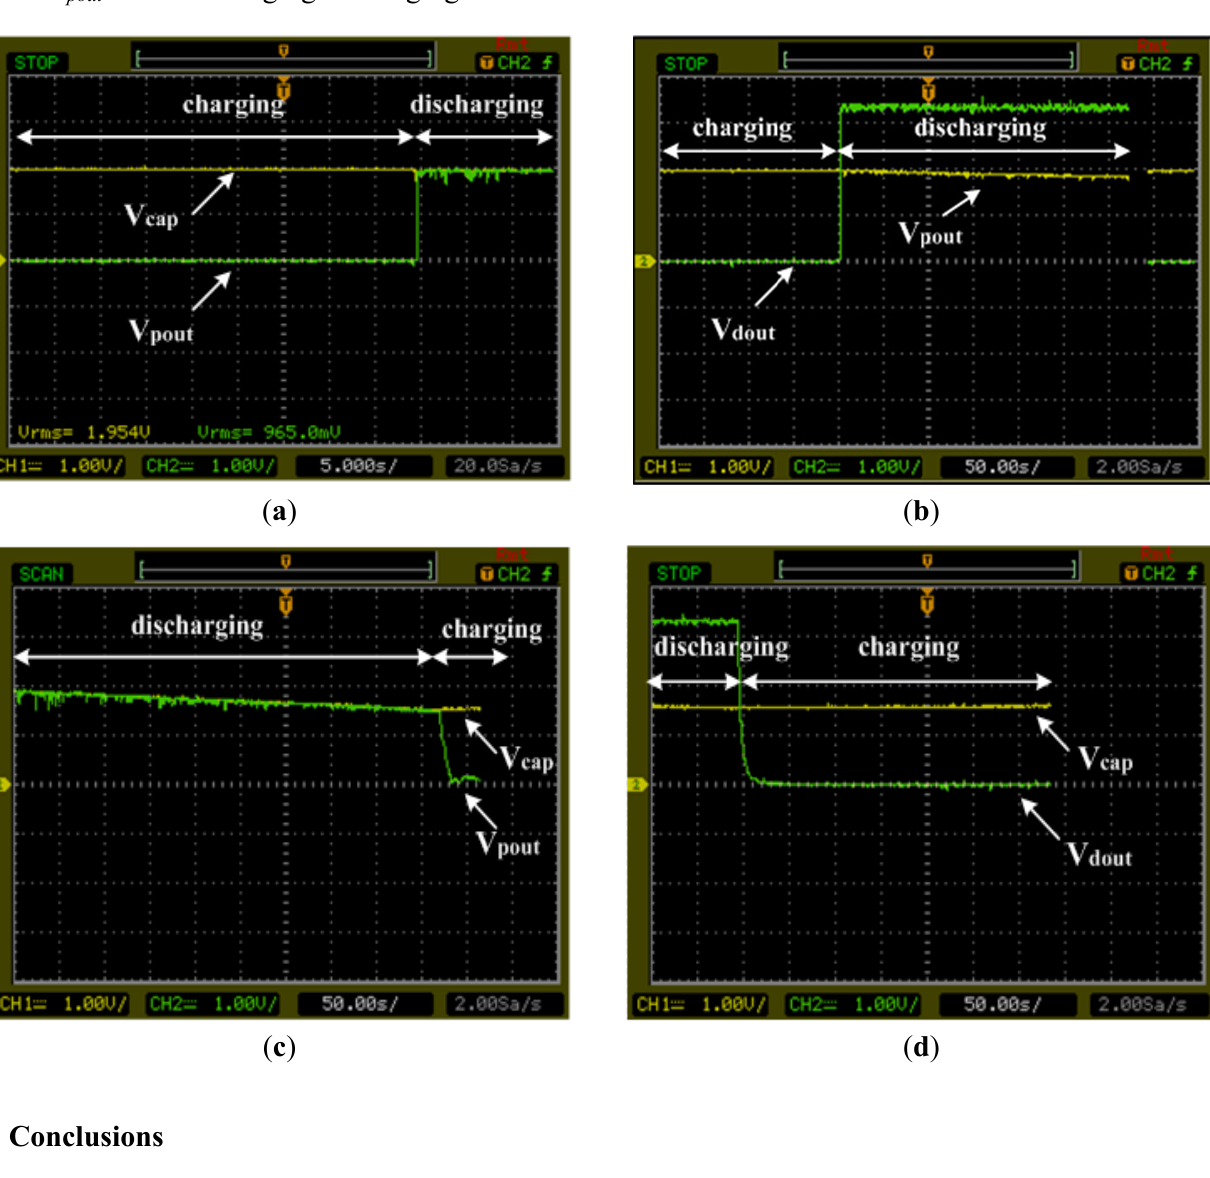
and V cap pout and cap